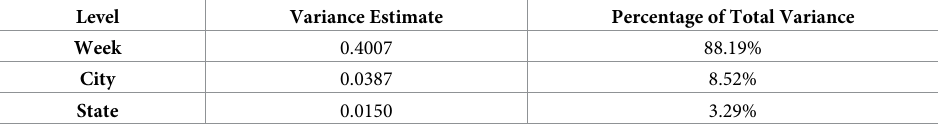
0.0150 3.29% Estimates correspond to the variances of the random intercepts for each level. The model has the logarithm